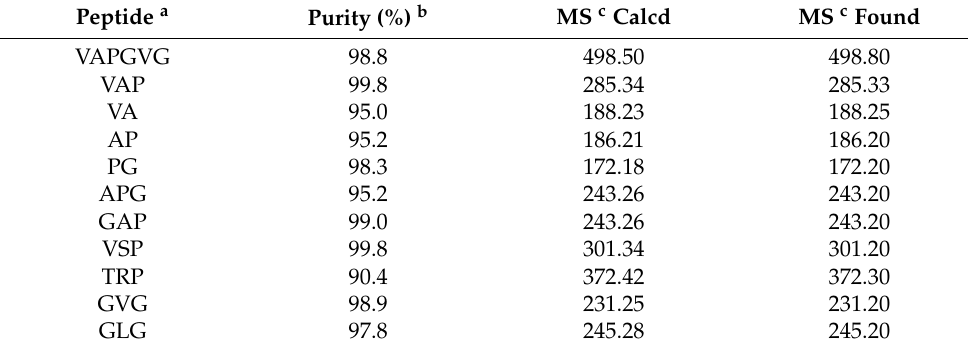
Table 1. Physicochemical properties of newly synthesized